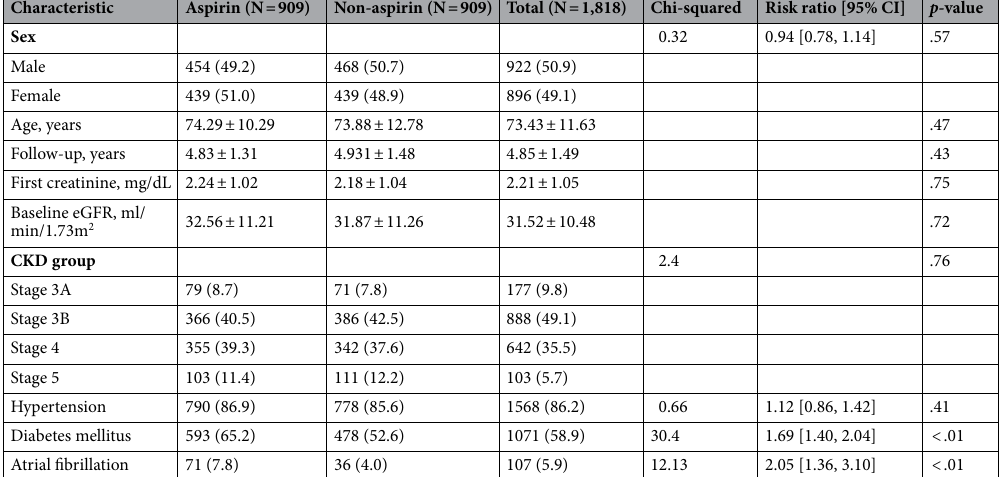
Table 1. Clinical and demographic characteristics of study population. Discrepancies between total number of patients, and number of patients for both groups are due to missing data. Values are presented as absolute numbers (percentage) or as mean ± SD.